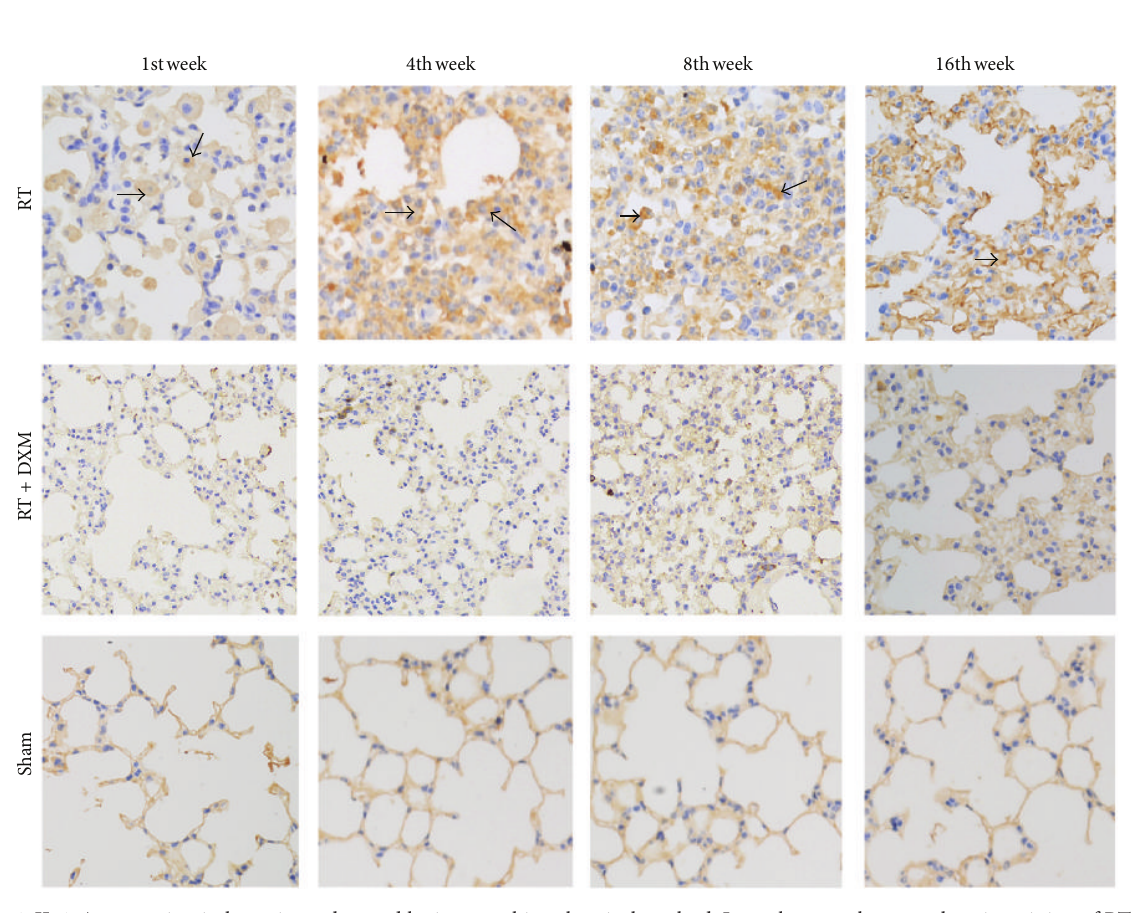
Alveolitis: ∗ 𝑃 < 0.05 compared with RT group.